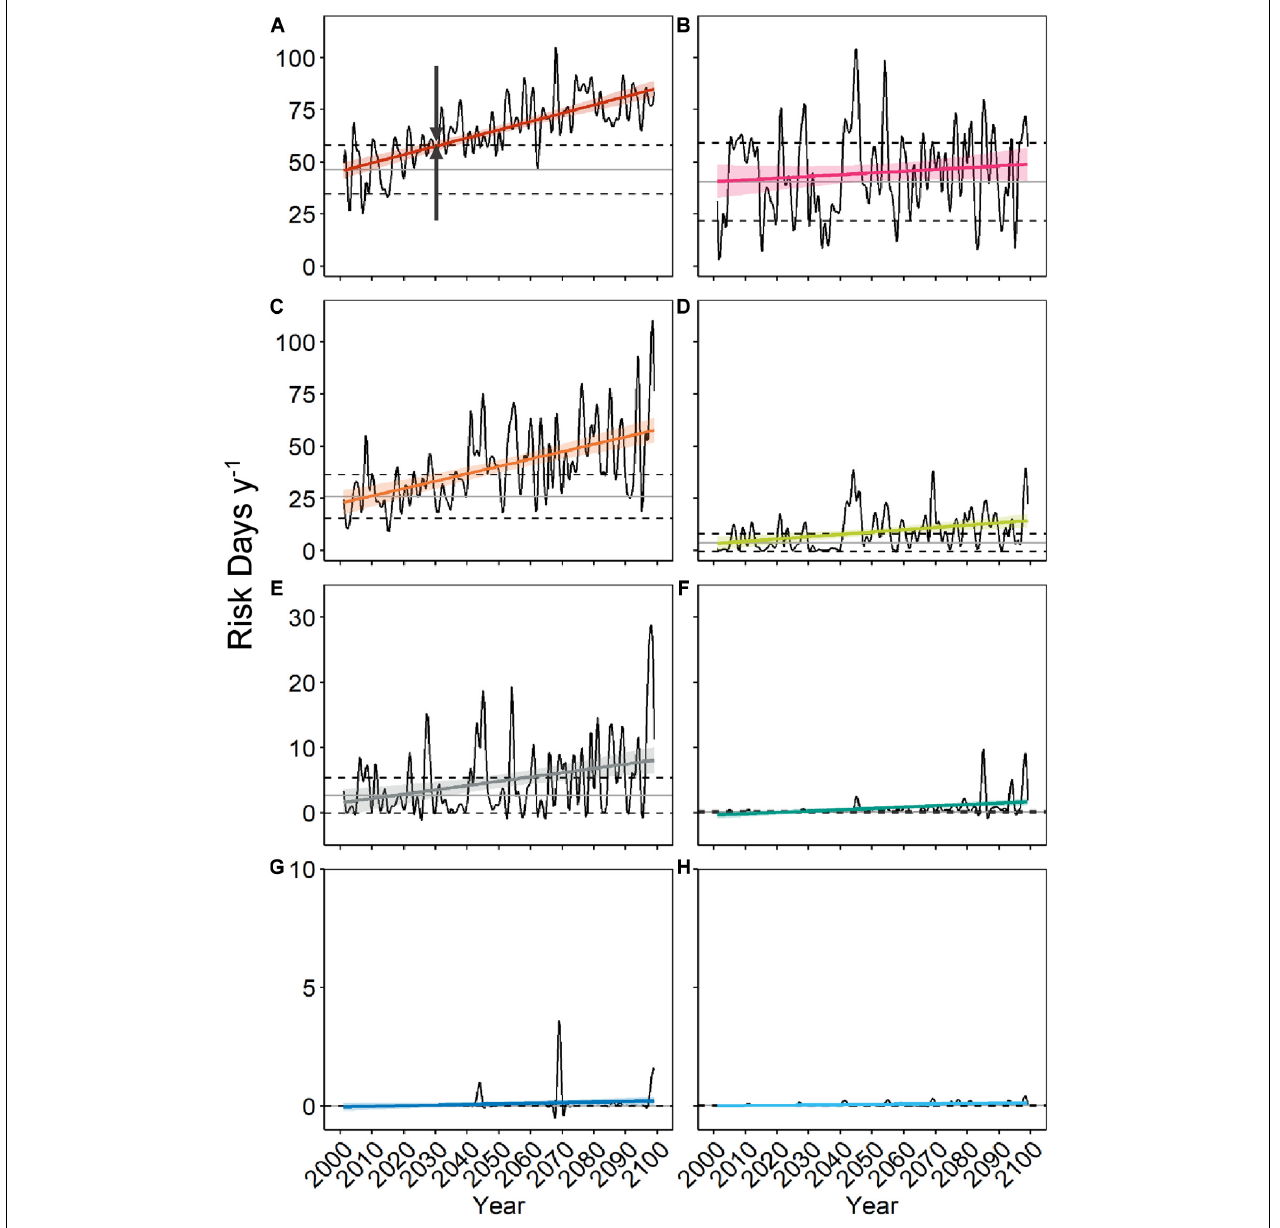
FIGURE 11 | Average number of risk days of Alexandrium catenella ≥ 1000 cells L − 1 per region (see Figure 1 – LSLE, Lower St. Lawrence Estuary) from May through October along Canada’s East coast under MPI-ESM-LR RCP 8.5 between 2001 and 2099 for (A) LSLE, (B) Chaleur Bay, (C) NW Gulf, (D) Prince Edward Island, (E) Magdalen Islands, (F) Lower North Shore, (G) Scotian Shelf, and (H) Bay of Fundy. Year of emergence is exemplified in (A) by the dark gray arrows. Refer to Figure 1 for color